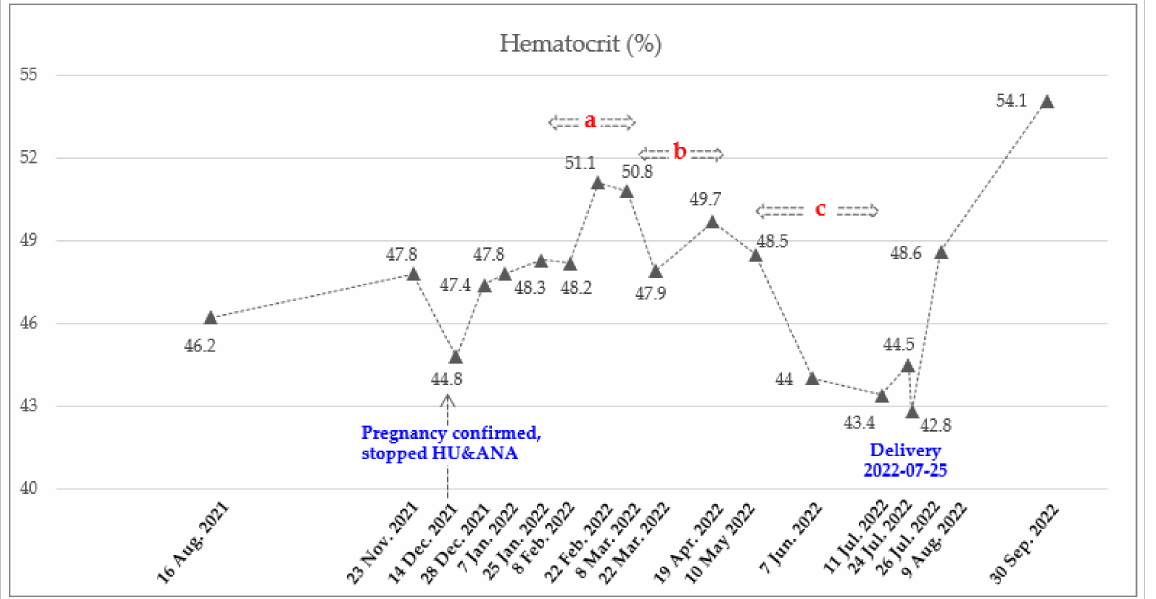
Figure 1. Dynamics of Hct count during pregnancy. Total of 8 doses of Ropeginterferon alfa-2b from 8 February 2022 to 11 July 2022. Injection schedule and dose: A. Every 2 weeks (250-350-500 mcg), b. Every 3 weeks (500 mcg), and c. Every 4 weeks (500